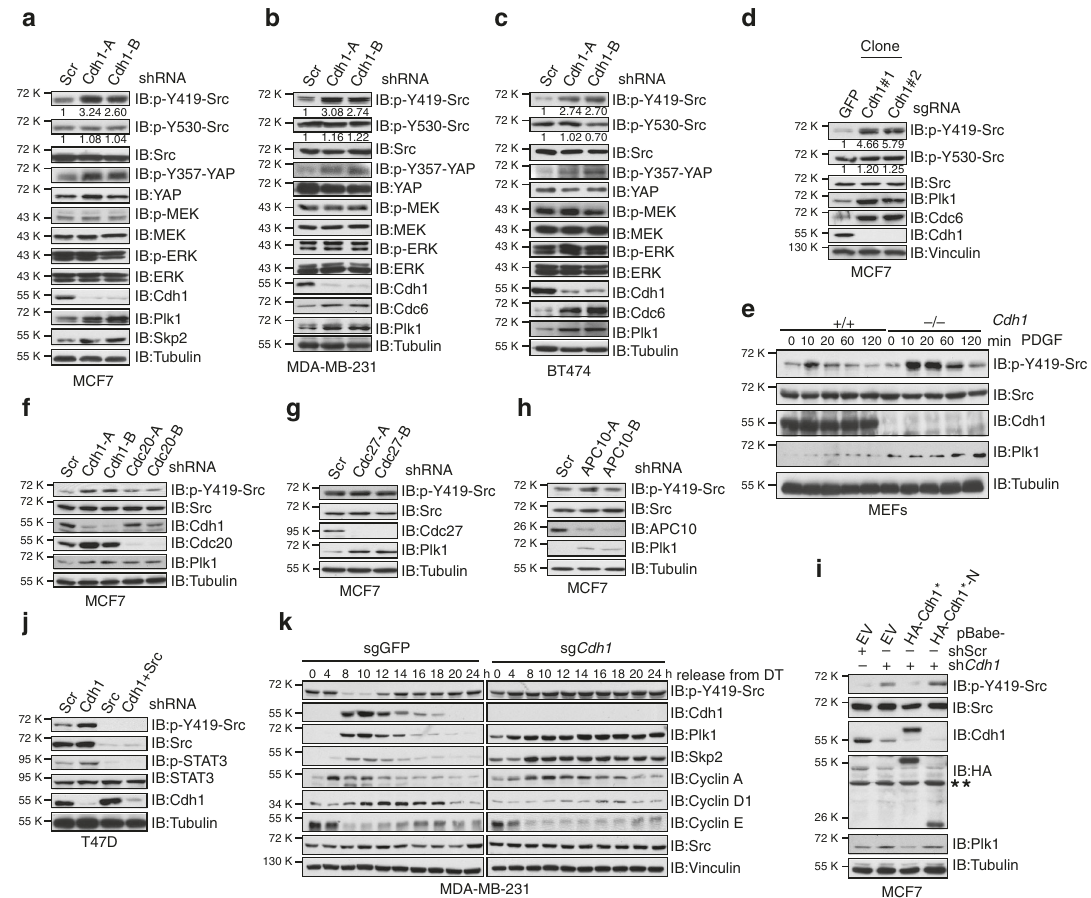
Fig. 1 Cdh1 negatively regulates Src kinase activity in an APC-independent manner. a – c Immunoblot (IB) analysis of MCF7 ( a ), MDA-MB-231 ( b ), and BT474 ( c ) cells infected with control (shScramble, shScr for short) or the indicated sh Cdh1 lentiviral shRNA constructs. The infected cells were selected with 1 μ g ml − 1 puromycin for 72 h before harvest. d CRISPR/Cas9-mediated deletion of Cdh1 activated Src. IB analysis of MCF7 cells infected with control (sgGFP) or sg Cdh1 lentiviral construct. The infected cells were selected with 1 μ g ml − 1 puromycin for 7 days before plating for single clone selection. e Src was activated in Cdh1 − / − MEFs. IB analysis of WT and Cdh1 − / − MEFs treated with 4 ng ml − 1 PDGF for the indicated periods of time after 16 h serum deprivation. f IB analysis of MCF7 cells infected with the indicated lentiviral shRNA constructs. The infected cells were selected with 1 μ g ml − 1 puromycin for 72 h before harvest. g , h IB analysis of MCF7 cells infected with control (shScr) or the indicated sh Cdc27 ( g ) and sh APC10 ( h ) lentiviral shRNA constructs. The infected cells were selected with 1 μ g ml − 1 puromycin for 72 h before harvest. i MCF7 cells stably expressing retroviral empty vector (EV), WT-, or N -Cdh1 were further infected with shScr or sh Cdh1 lentiviral constructs as indicated. The infected cells were selected with 1 μ g ml − 1 puromycin for 72 h before harvest. *Cdh1 cDNA used in this experiment has been mutated to escape sh Cdh1 -mediated gene silencing. ** indicates nonspeci fi c bands. j IB analysis of T47D cells infected with the indicated lentiviral shRNA constructs. The infected cells were selected with 1 μ g ml − 1 puromycin and 100 μ g ml − 1 hygromycin for 72 h before harvest. k IB analysis of WCL derived from sgGFP- and sg Cdh1 -infected MDA-MB-231 cells that were synchronized at the G1 – S boundary by double-thymidine block and then released back into the cell cycle for the indicated periods of